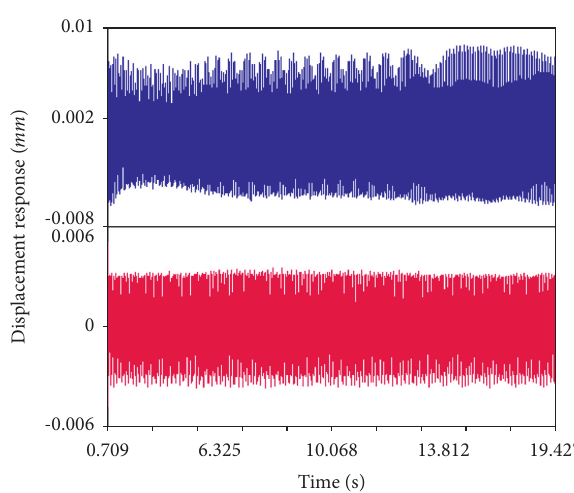
Figure 28: Comparison of time-domain response.